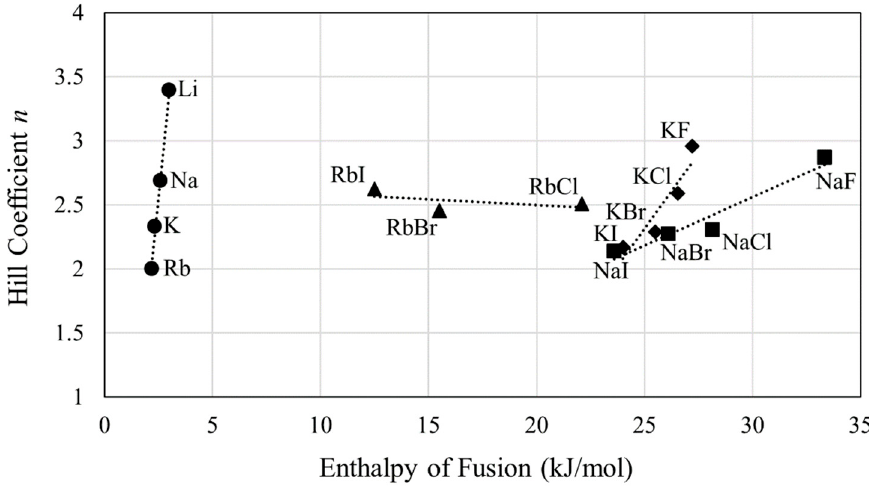
Figure 6. Enthalpy of fusion and Hill Coefficient correlations for the alkali metals and alkali halides. Fusion energies were taken from the CRC Handbook [51].